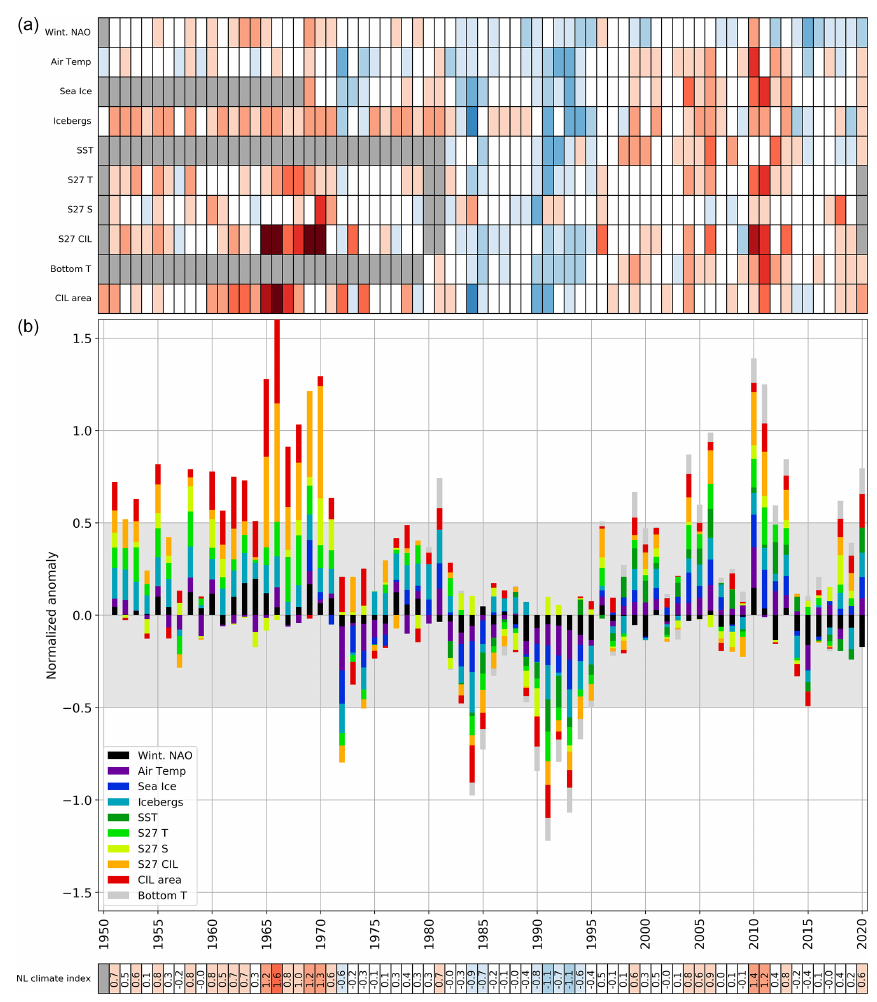
Figure A8. Same as Fig. 12 but using a climatology referenced to the 1981–2010